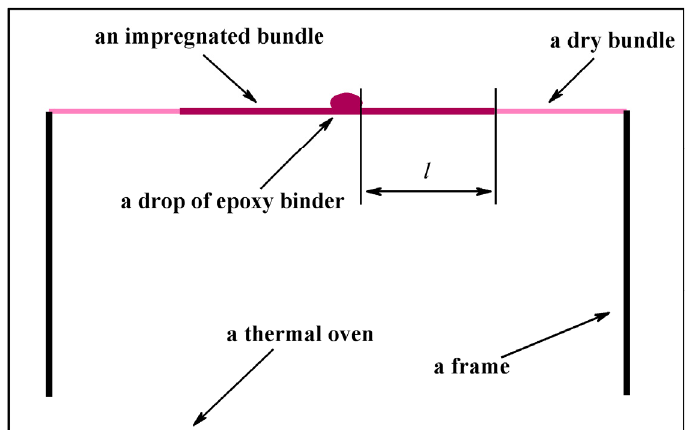
Figure 1. Scheme for assessing the impregnation of a carbon fiber bundle with an epoxy binder. The viscosity ( η ) of nanoparticle dispersions was measured on a rotational rheometer Physica MCR 301 (Anton Paar, Graz, Austria) using a cone–plate measuring unit (plate diameter: 40 mm, cone–plate angle: 1°) by a stepwise increase in shear rate ( 𝛾(cid:4662) ) from 0.01 s − 1 to 100 s − 1 at 20 °C. The viscosity growth of fiber-free epoxy binders was evaluated